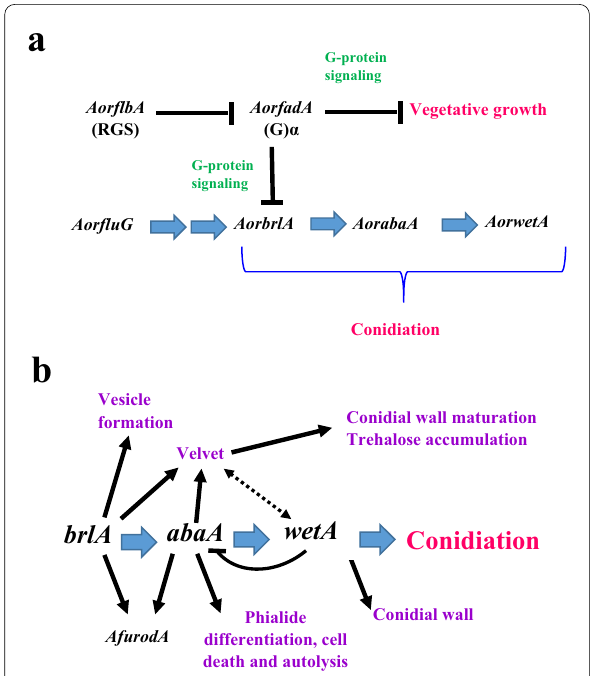
Fig. 4 Schematic presentations showing model for conidiation regulation in A. oryzae as proposed by Ogawa et al., 2010 ( a ); and central regulatory pathway in Aspergillus fumigatus conidiation as proposed by Yu, 2010 ( b